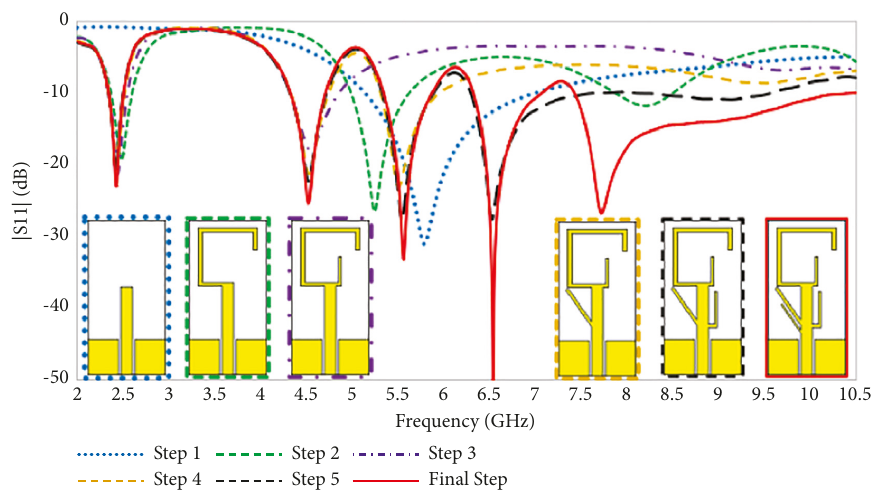
Figure 2: Steps of design evolution.